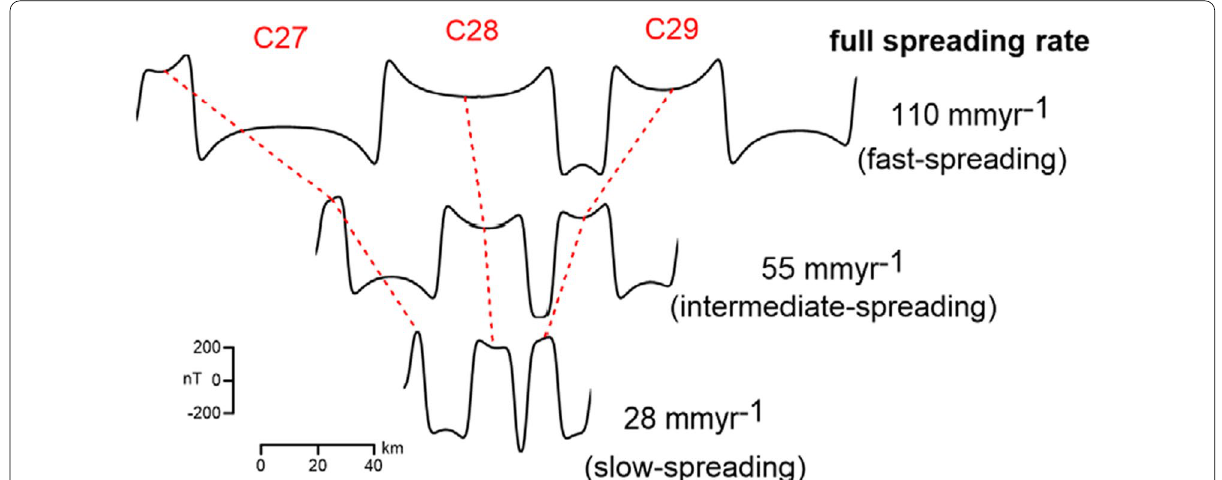
Fig. 8 Marine magnetic anomalies of the polarity chron C27-29 with different spreading